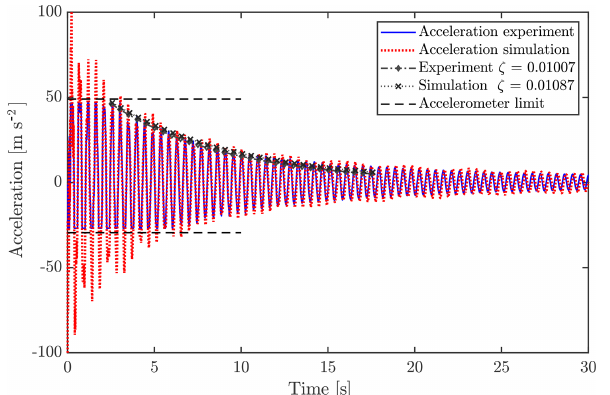
Figure 9. Power spectral density (using Welsh estimate) of accel- eration signals of the experiment and